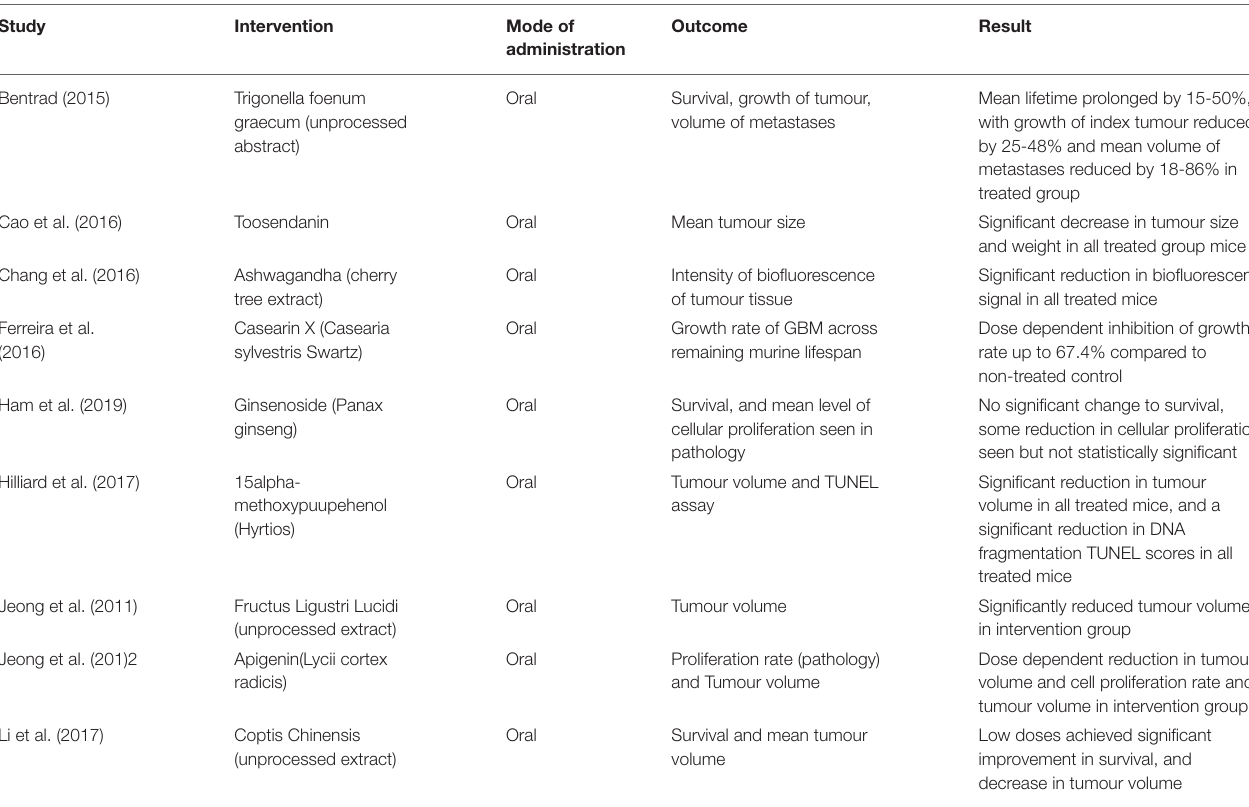
TABLE 2 | Summary of study characteristics of included articles examining murine